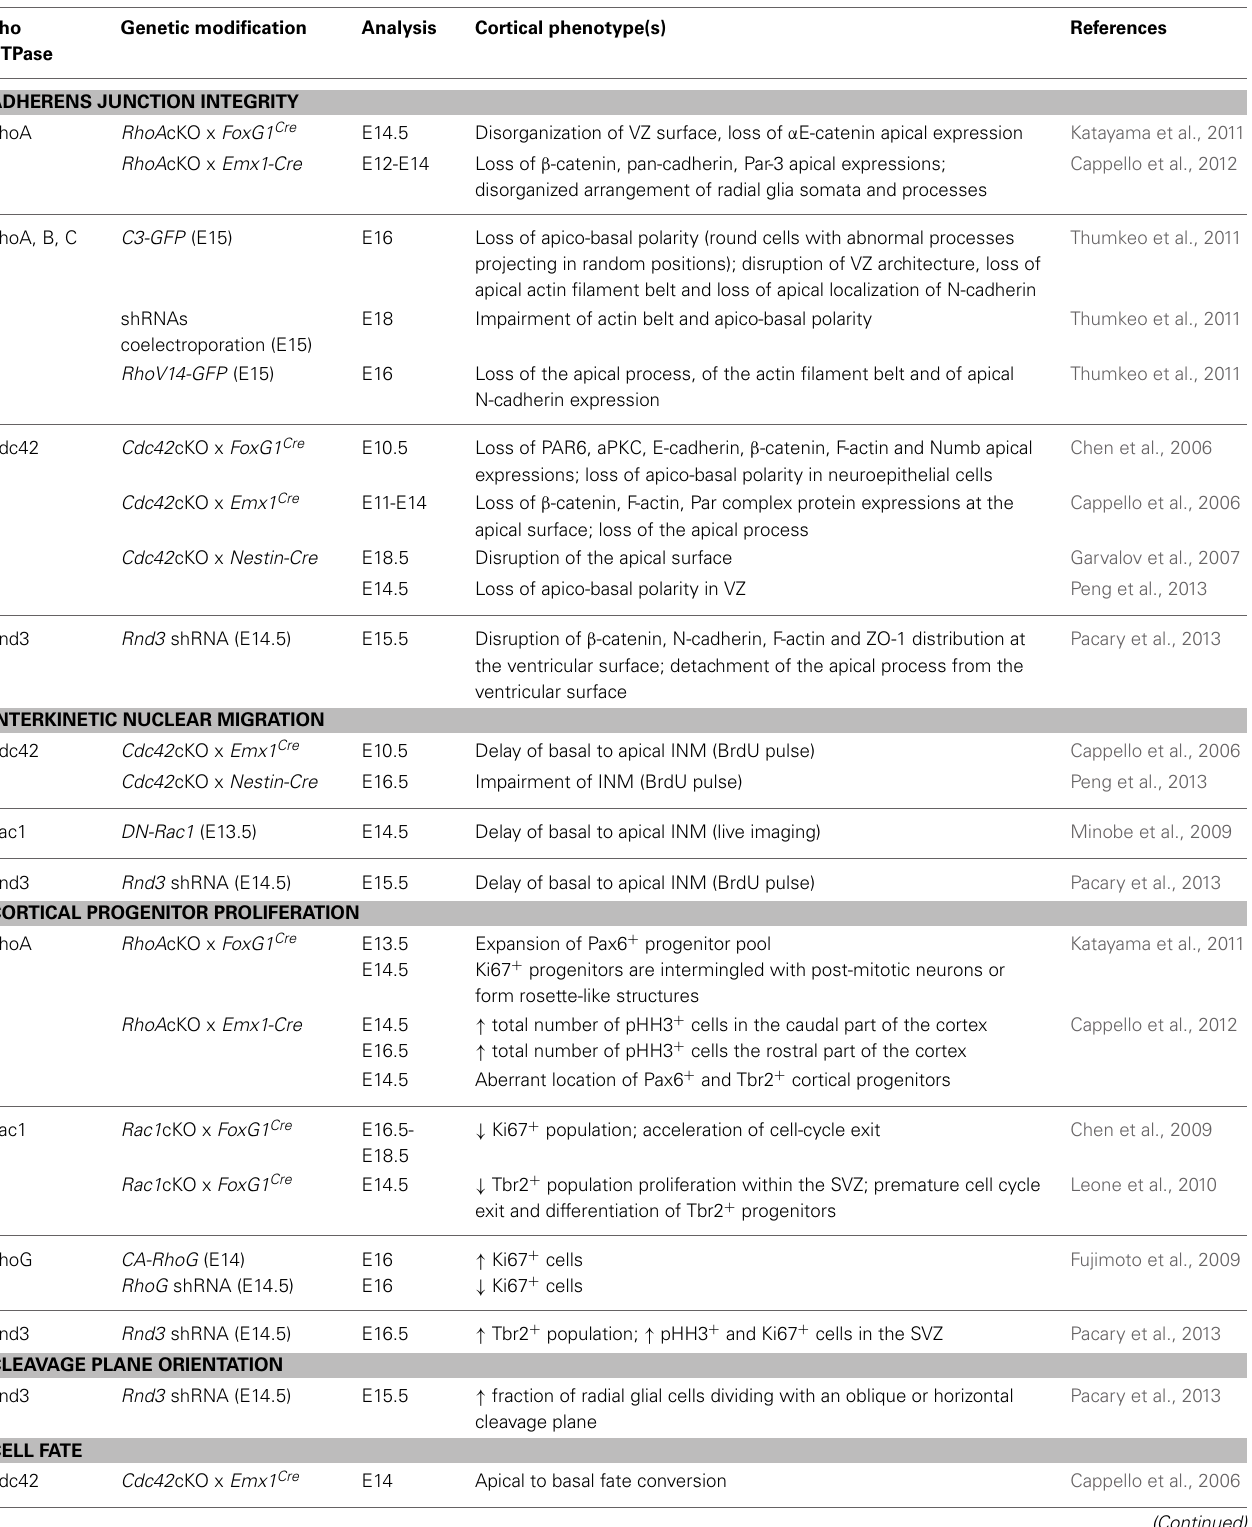
Table 1 | Regulation of cortical projection neuron development by Rho GTPases ( in vivo studies). Rho